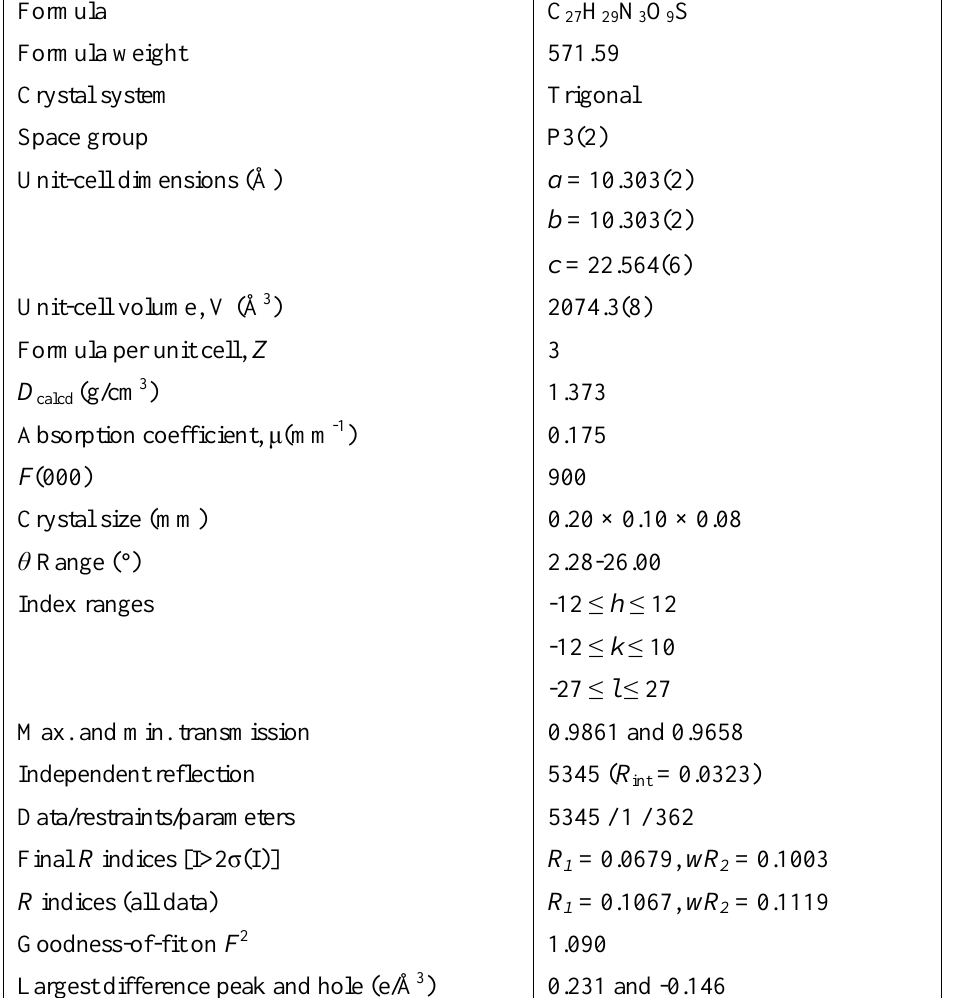
Table 2. Crystal and experimental data for compound